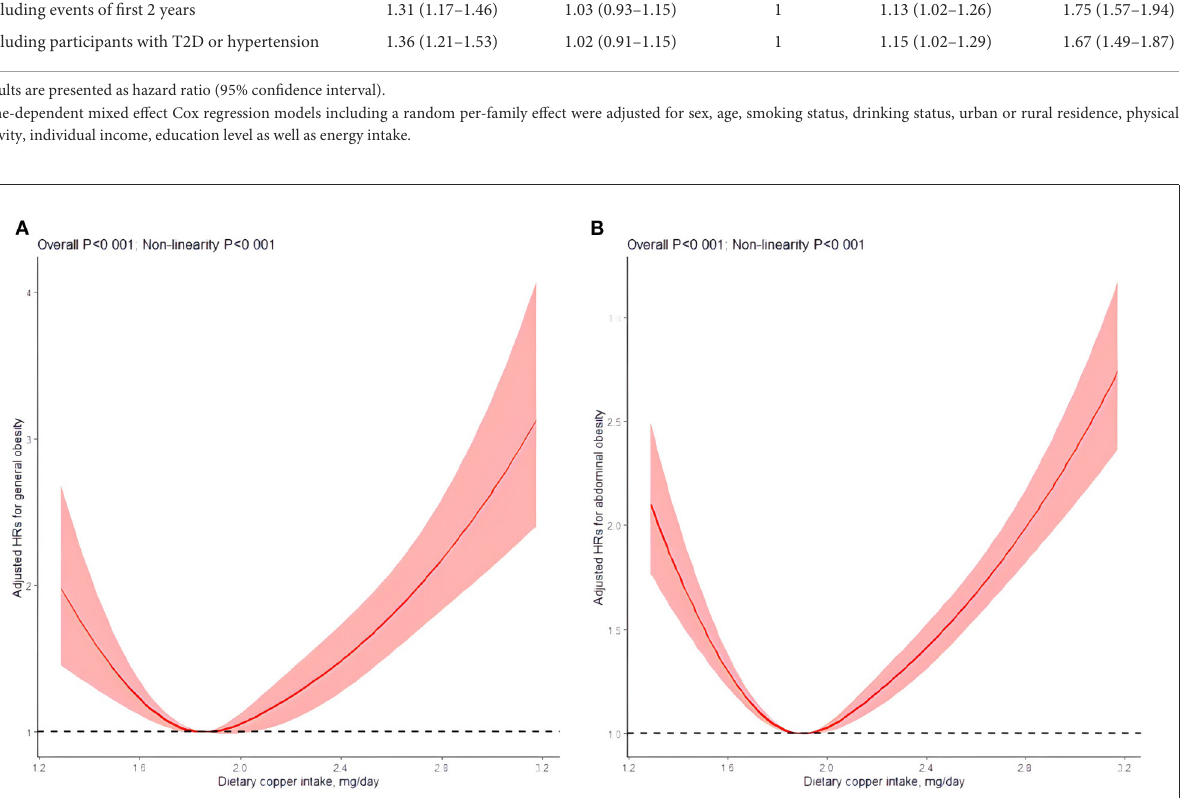
FIGURE2 Associations of dietary copper intake with risk of general obesity (A) and abdominal obesity (B) by restricted cubic spline plots. Plots were adjusted for sex, age, smoking status, drinking status, urban or rural residence, physical activity, individual income, education level, as well as energy intake. P for overall stems from the joint Wald test for the linear and nonlinear term of RCS; P for non-linearity is derived from the Wald test for the non-linear term of the